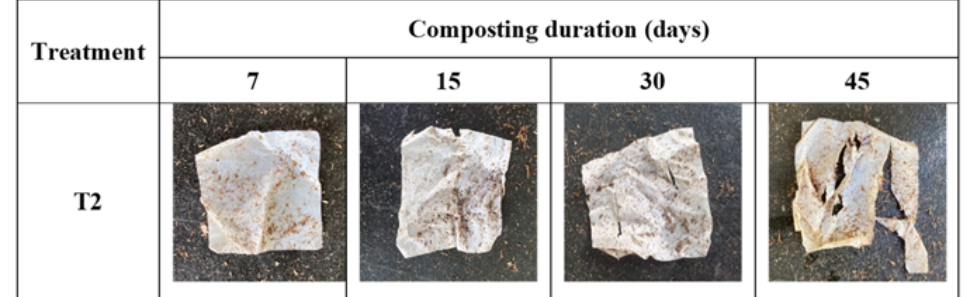
Figure 3. Physical appearance of bioplastic bags from T2.